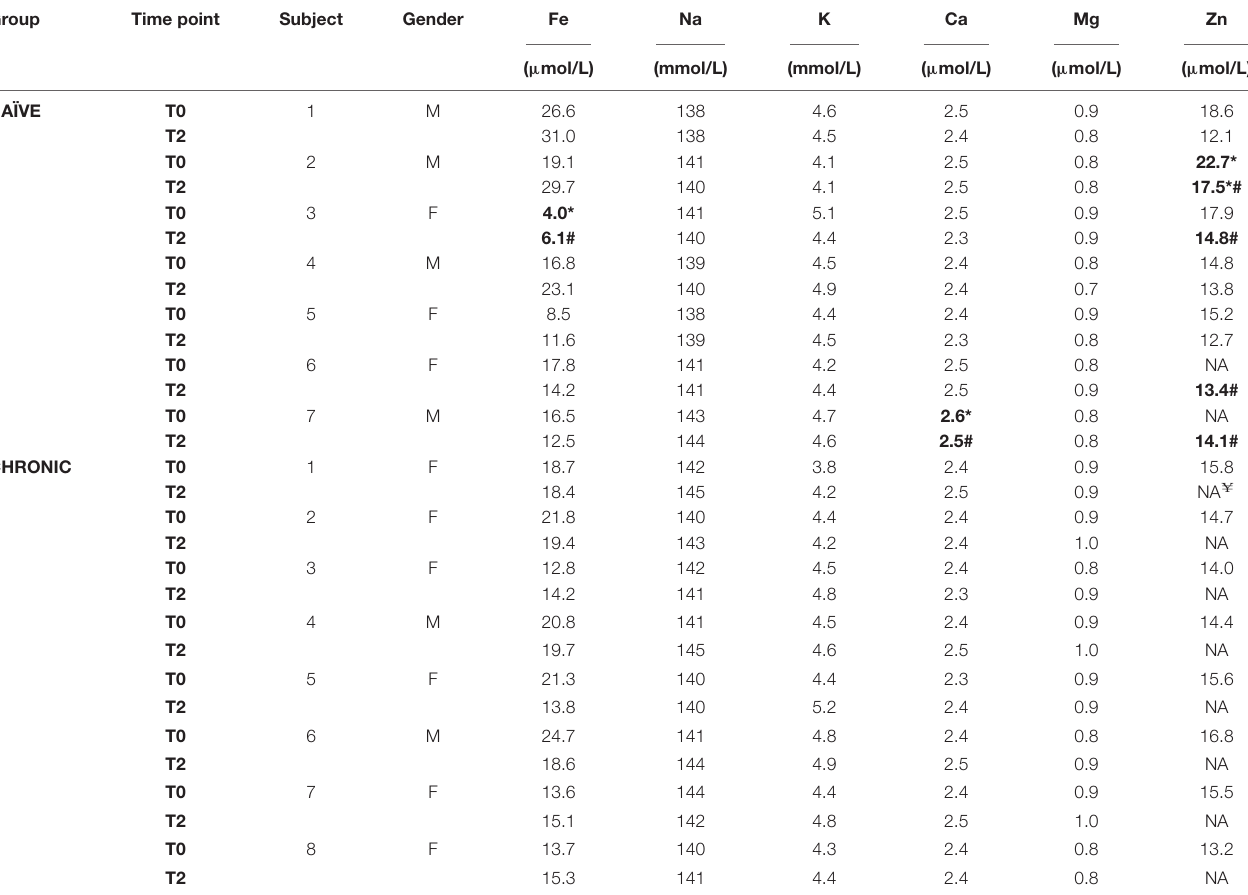
TABLE 3 | Results of the mineral analyses in serum of the subjects enrolled in the MMBP study (NCT04607018), sampled at the beginning of the study (T0) and after 28 days of PMA-zeolite supplementation (T2). Group Time point Subject